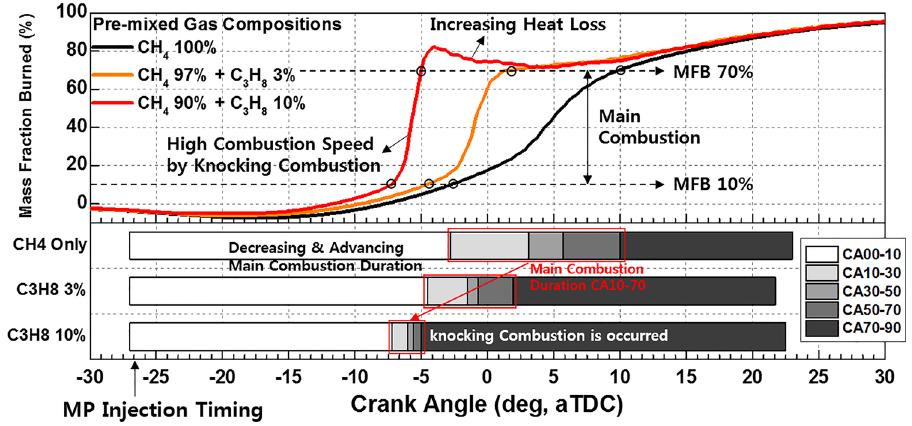
Figure 10. Variation in the MFB with the C 3 H 8 mixture